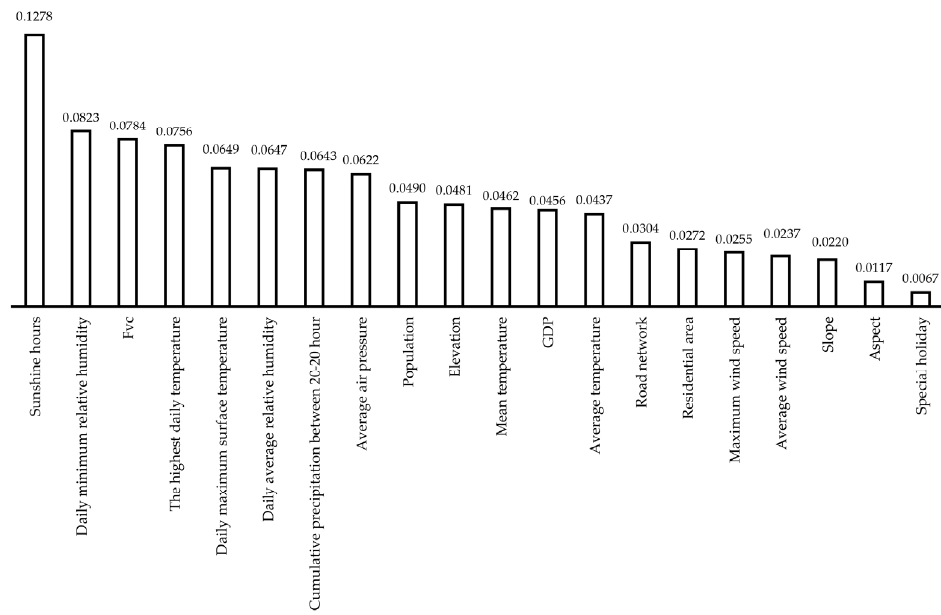
Figure 4. Influences of factors on the fire risk model.